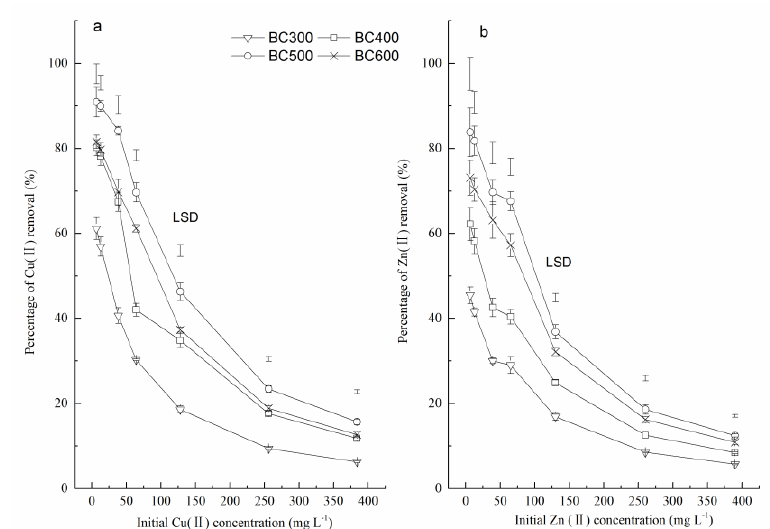
Figure 6. Adsorption isotherms of Cu(II) ( a ) and Zn(II) ( b ) by BCs (reaction temperature 25 °C; BC dosage 5 g·L −1 ; initial solution pH 5.0; contact time 1440 min). Error bars represent standard error ( n = 3).